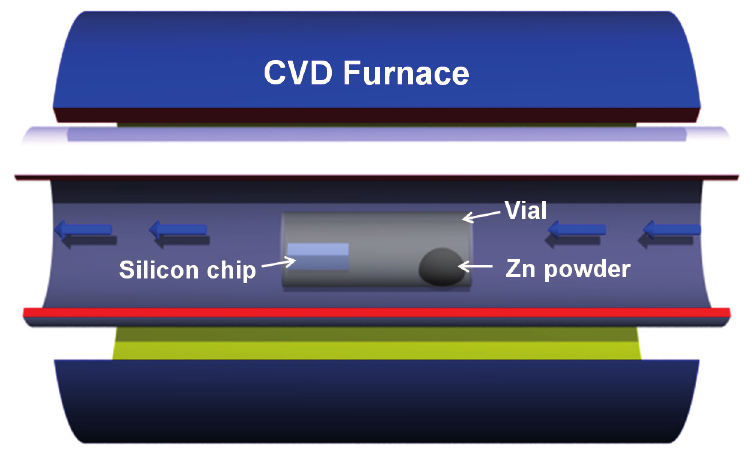
Figure 3. Illustration of our proposed ZnO nanocomb fabrication